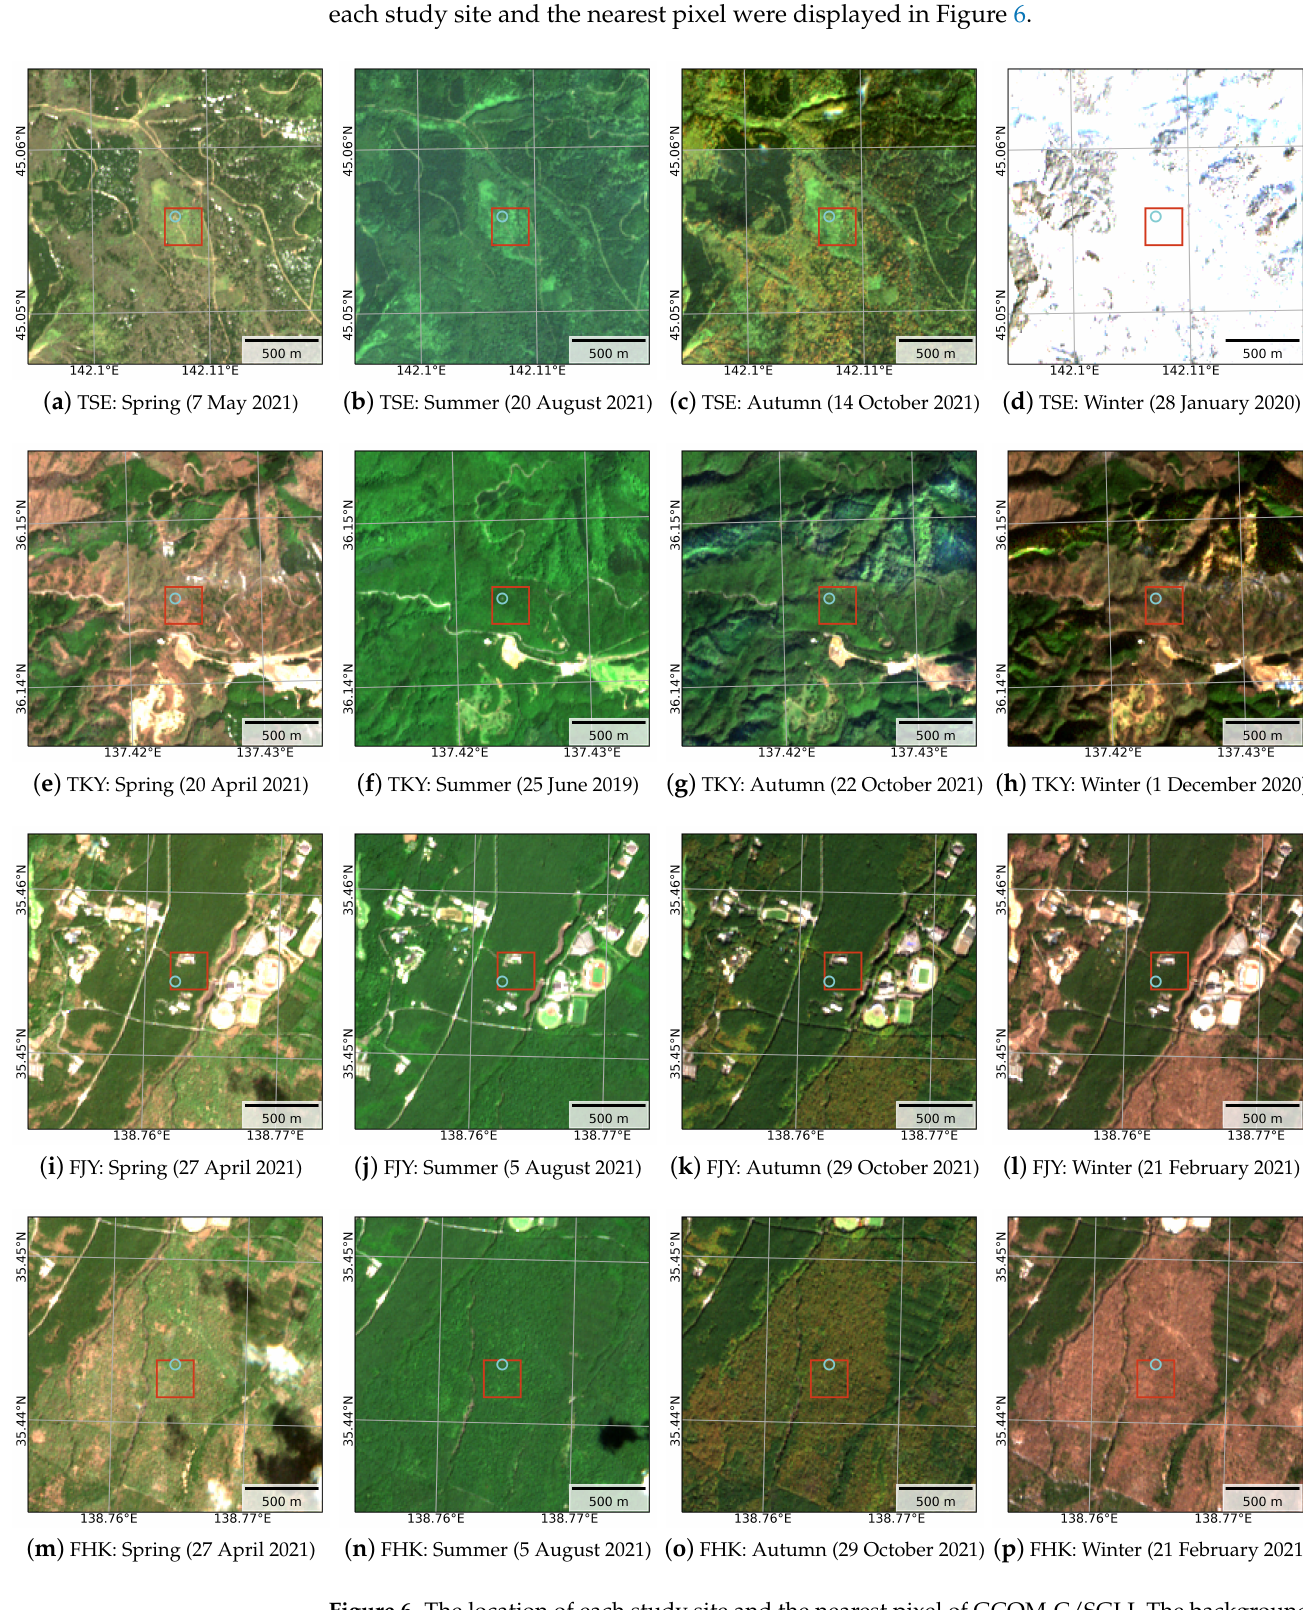
Figure 6. The location of each study site and the nearest pixel of GCOM-C/SGLI. The background true color image was created from Sentinel-2 level 2 products. The cyan circle indicates the location of the observation tower. The red square indicates a range of the nearest pixel of